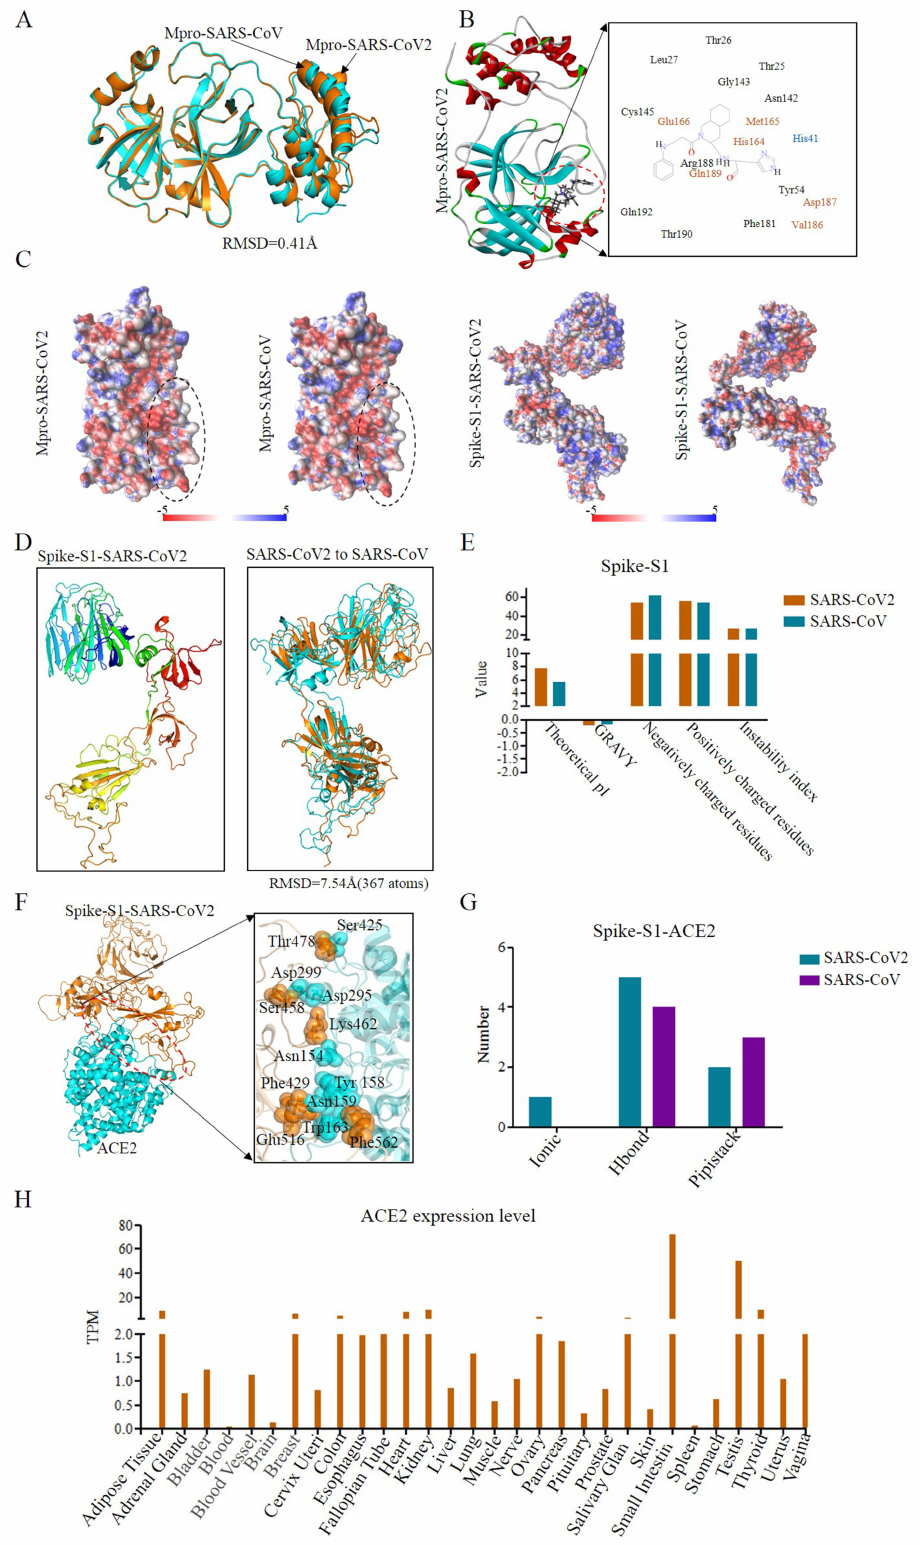
Figure 3. Structural pharmacology analysis of Mpro and Spike. (A) Structural alignment of SARS-CoV-2 Mpro and corresponding protein of SARS-CoV (PDB ID: 5c5o). (B) A ligand (SDJ) of SARS-CoV interacts with Mpro of SARS-CoV-2. Orange, cyan, and black represent h bond, Pipistack, and VDW. (C) Surface electrostatic potential values of Mpro and Spike-S1 for SARS-CoV-2 and SARS- CoV. (D) Structure comparison of SARS-CoV-2 Spike-S1 and SARS-CoV Spike-S1 (orange cartoon). (E) Physical and chemical parameters, including theoretical pI (isoelectric point), GRAVY (grand average of hydropathicity), negatively/ positively, and instability index of Spike-S1 for SARS-CoV-2 and SARS-CoV. (F) The complex of Spike-S1 for SARS-CoV-2 and ACE2, and the interaction sites between two proteins. (G) The interaction force type of Spike-S1 and ACE2 in SARS-CoV-2 and SARS-CoV. (H) ACE2 expression levels in different human